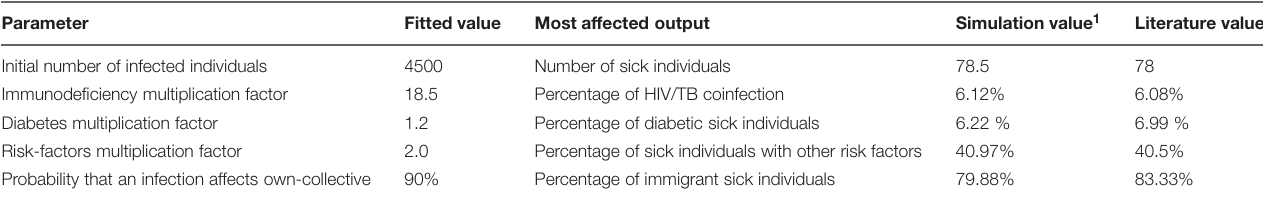
TABLE 2 | Values of the fitted input parameters, together with most affected outputs of the 1-year simulation compared with values in the literature (Orcau i Palau et al., 2015). Parameter Fitted